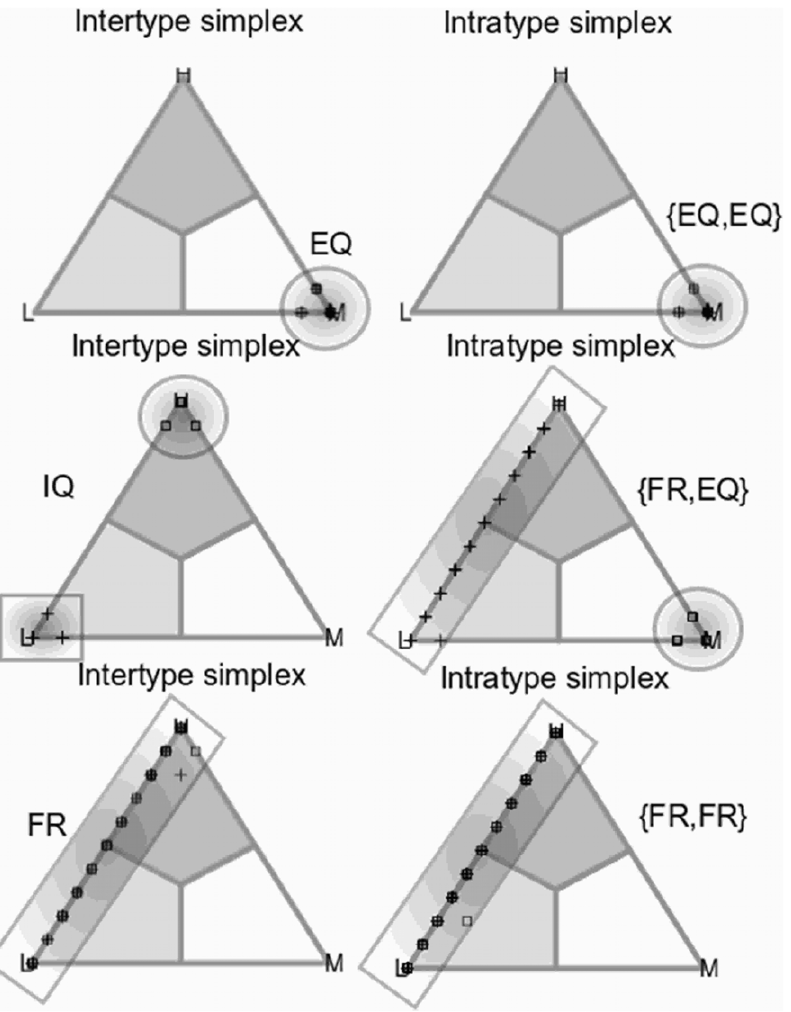
Figure 5. Most frequent persistent regimes of the transient dynamics for the intertype and intratype bargaining games. The bargaining between different groups (intertype) can reach the EQ state (top-left simplex), the IQ state (middle-left simplex) or the FR regime (bottom- left simplex). In the bargaining within groups (intratype) we have shown the combination of {EQ,EQ} when both groups coordinate in the EQ state (top-right simplex), {EQ,FR} when one group is in the EQ state but the other is in the FR regime (middle-right simplex), and when both groups stay in the FR regime (bottom-right simplex).